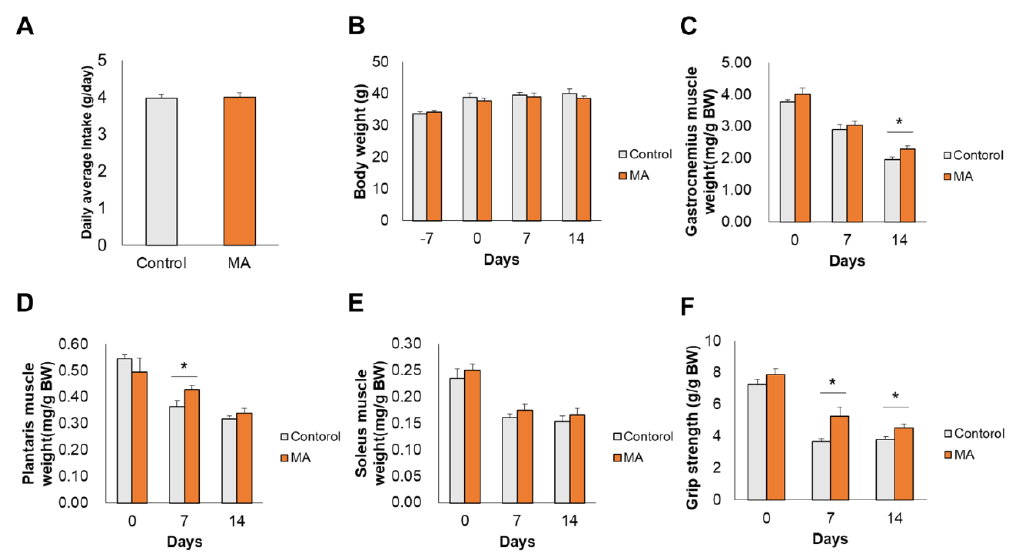
Figure 1. Maslinic acid (MA) prevented skeletal muscle atrophy following denervation. ( A ) Food intake, ( B ) body weight, ( C ) gastrocnemius muscle weight, ( D ) plantaris muscle weight, ( E ) soleus muscle weight, and ( F ) grip strength. Values are shown as mean ± SEM ( n = 3-15), * p < 0.05 vs. control.